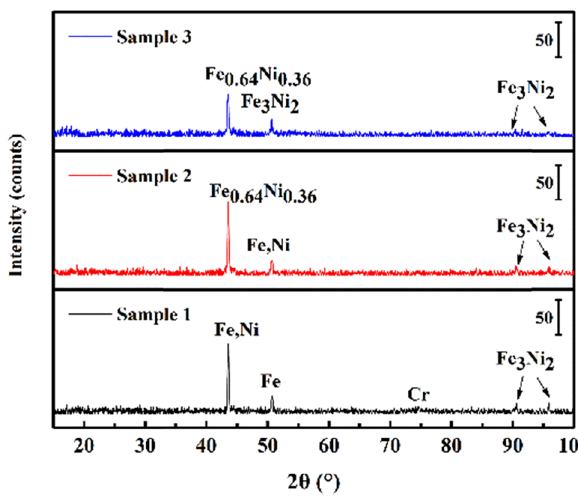
Figure 7: XRD di ff raction patterns of each sample coating.